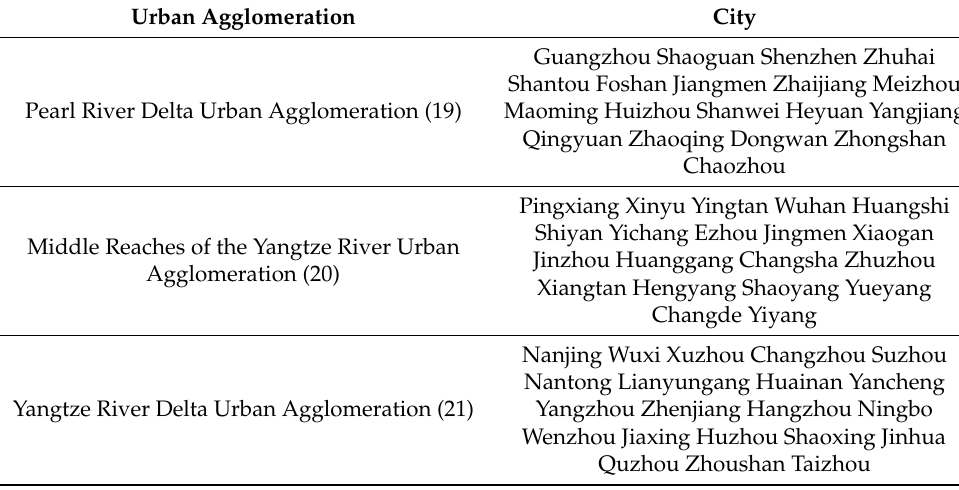
Table 1. The cities included in the five urban